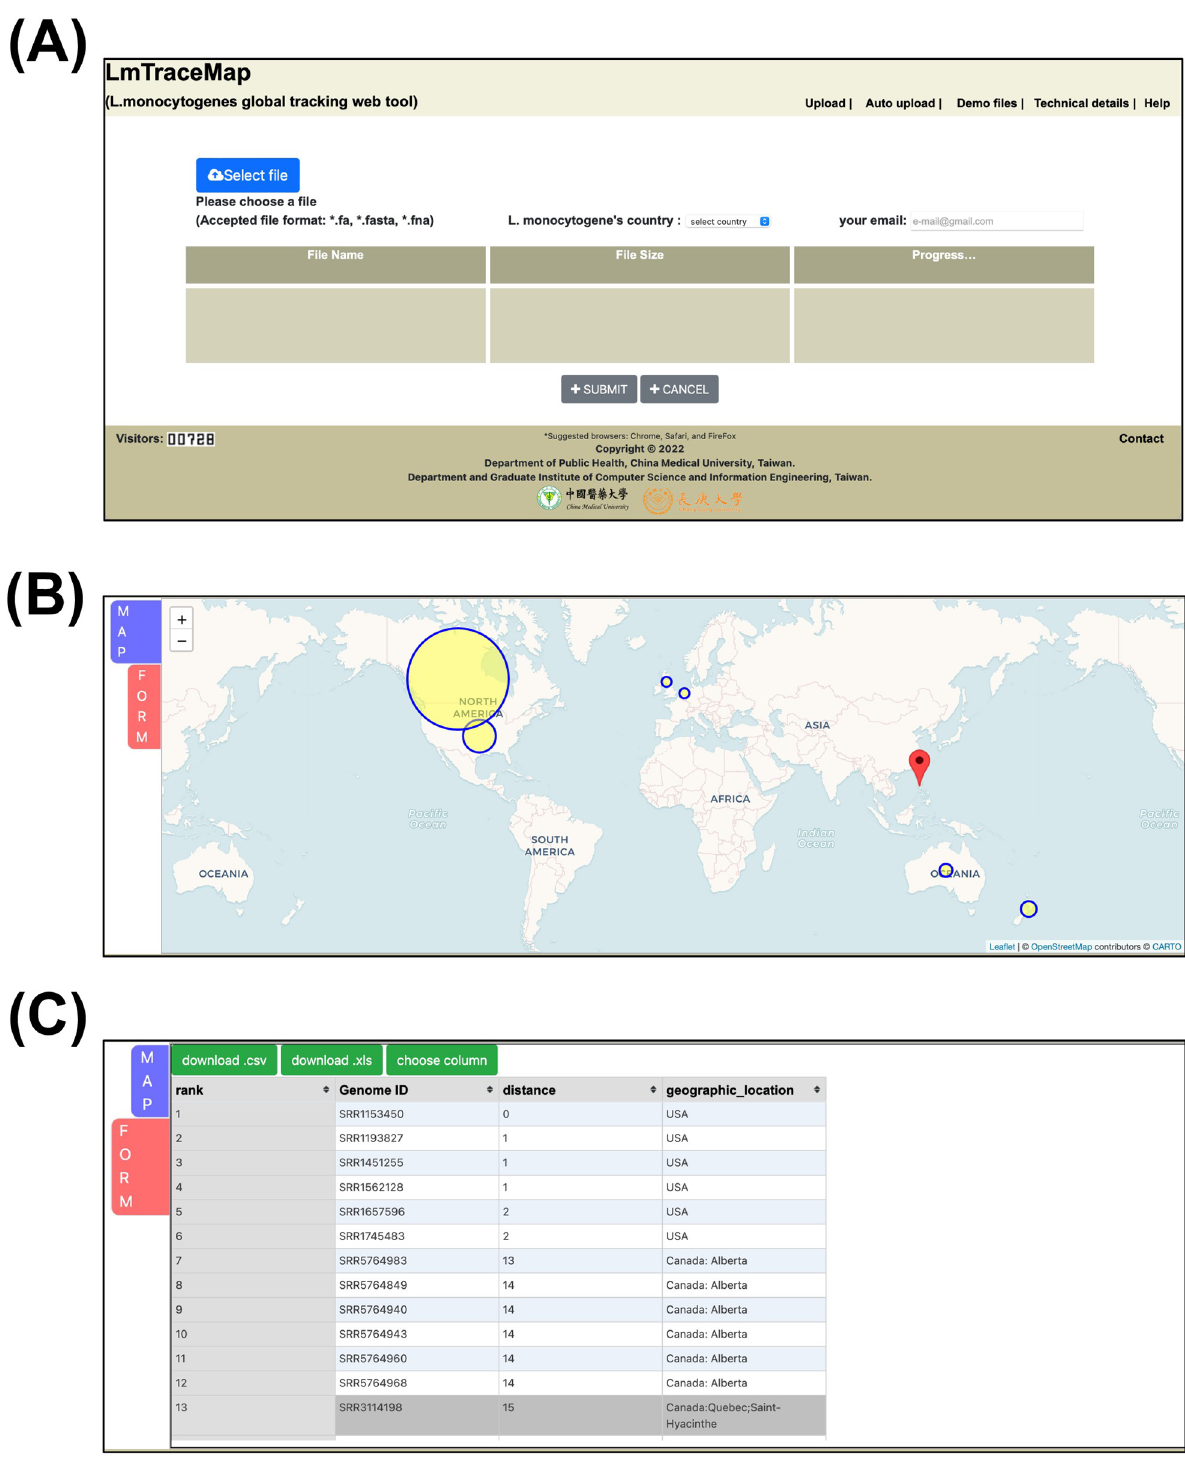
Fig 2. LmTraceMap screenshot. a) LmTraceMap server homepage; b) MAP tag of result page; c) FORM tag of result page. (Base map and data from OpenStreetMap and OpenStreetMap Foundation. Reprinted from OpenStreetMap under a CC BY license, with permission from